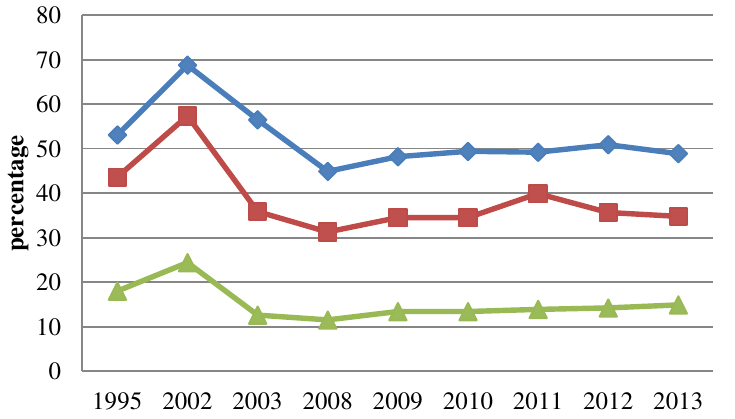
Fig. 1. Unemployment rates by age group, SA, 1995-2013 Source: Stats SA (2014), QLFS, Q4 (2010), QLFS Q3(2013), Q1